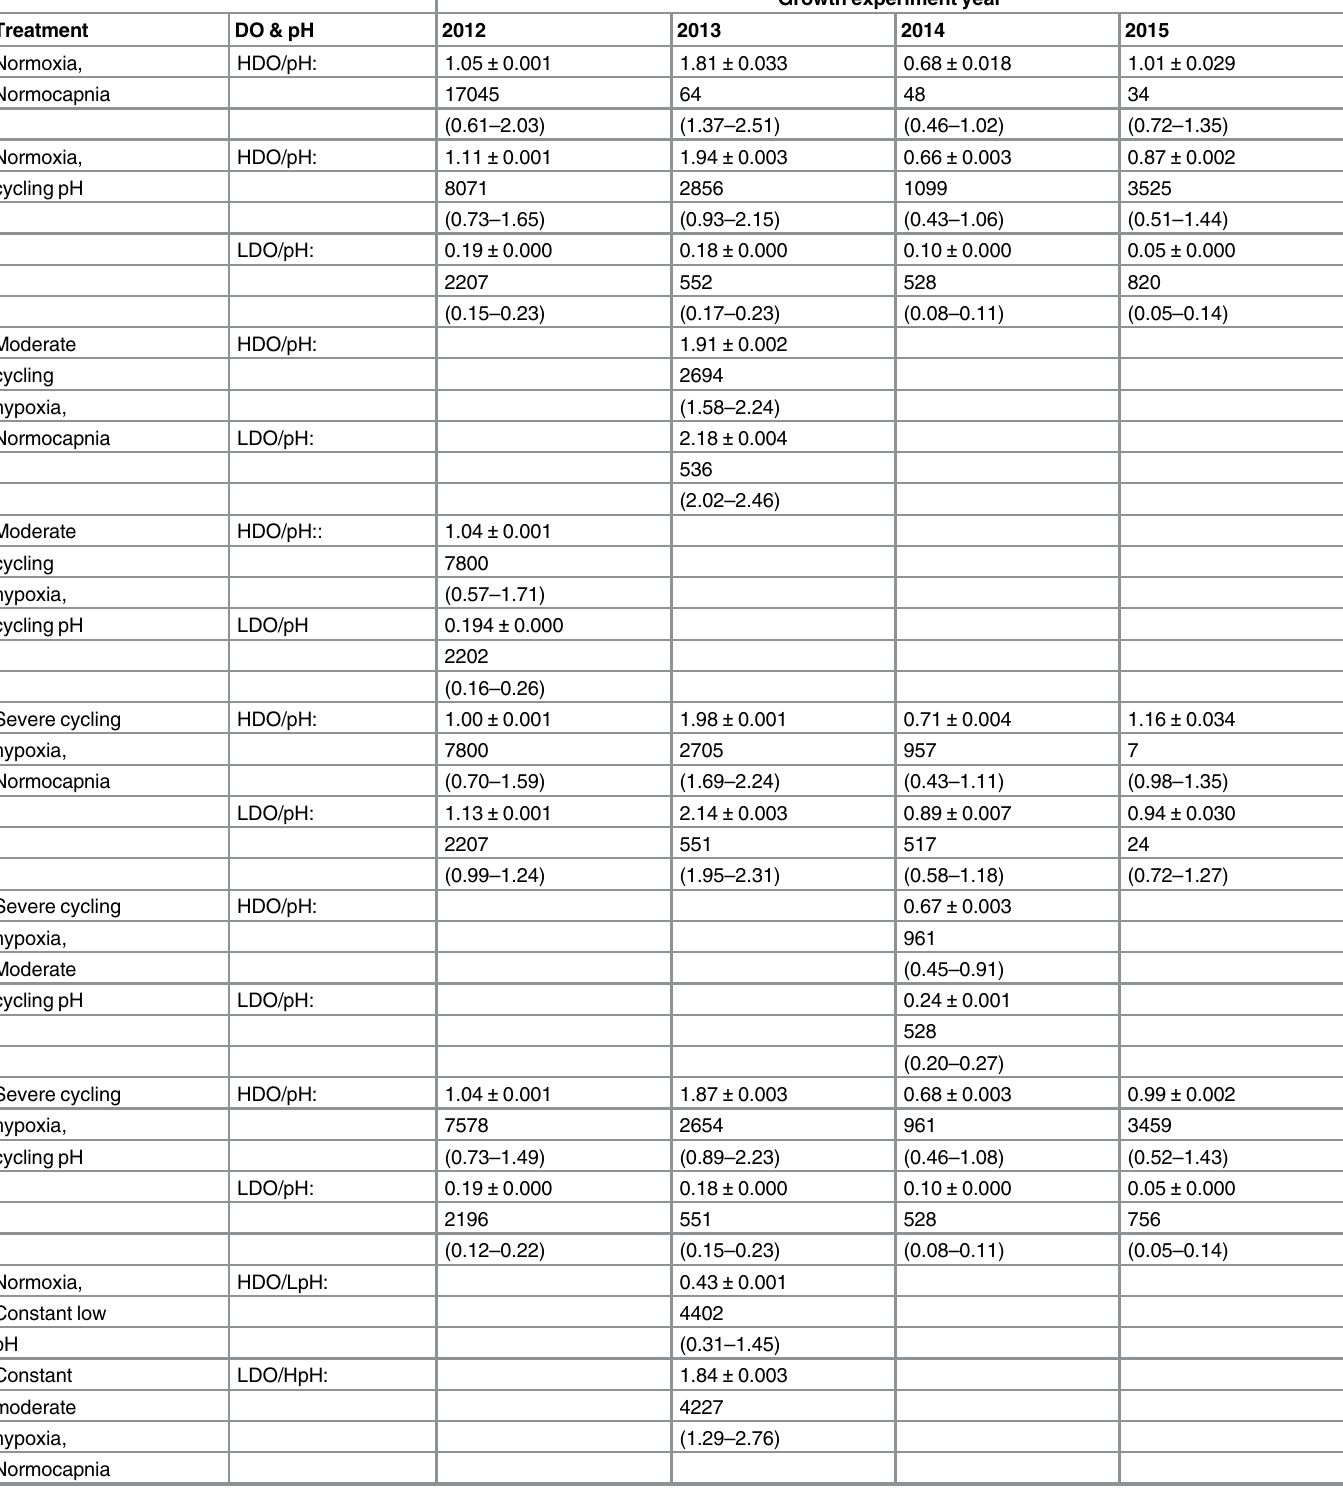
Table 8. Mean ± SE, n, and range of calcite saturation states by